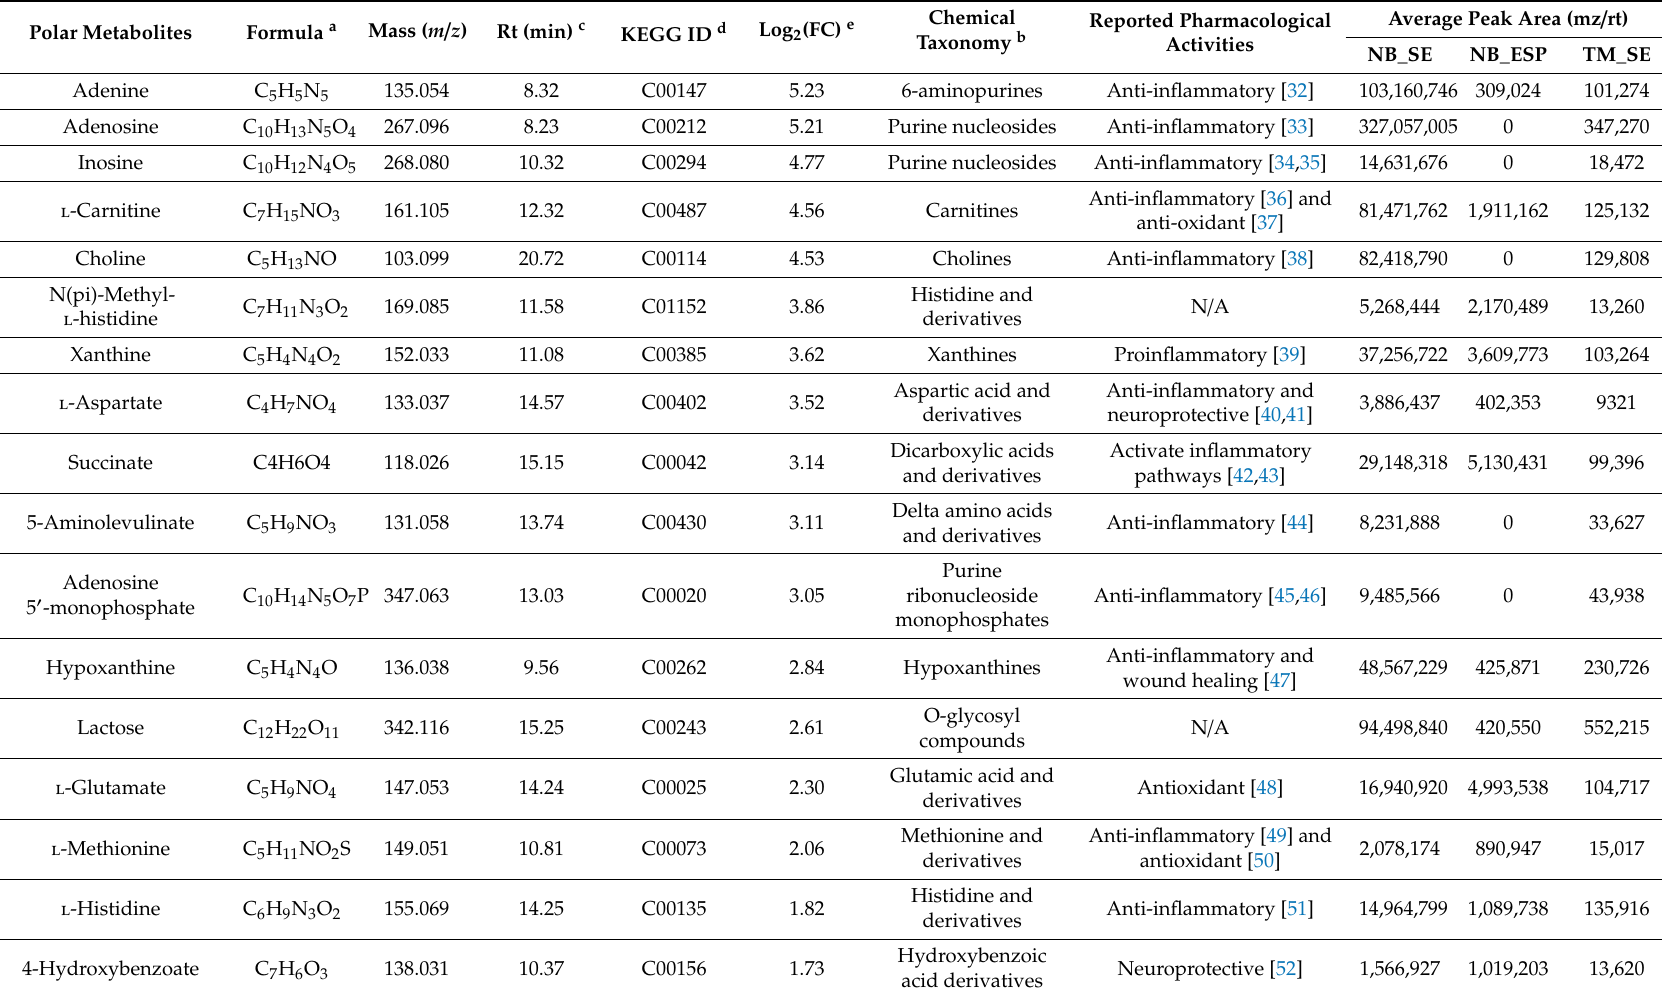
Table 1. Polar metabolites (MSI-I identified) of infective stages of N. brasiliensis (L3) and T. muris (embryonated